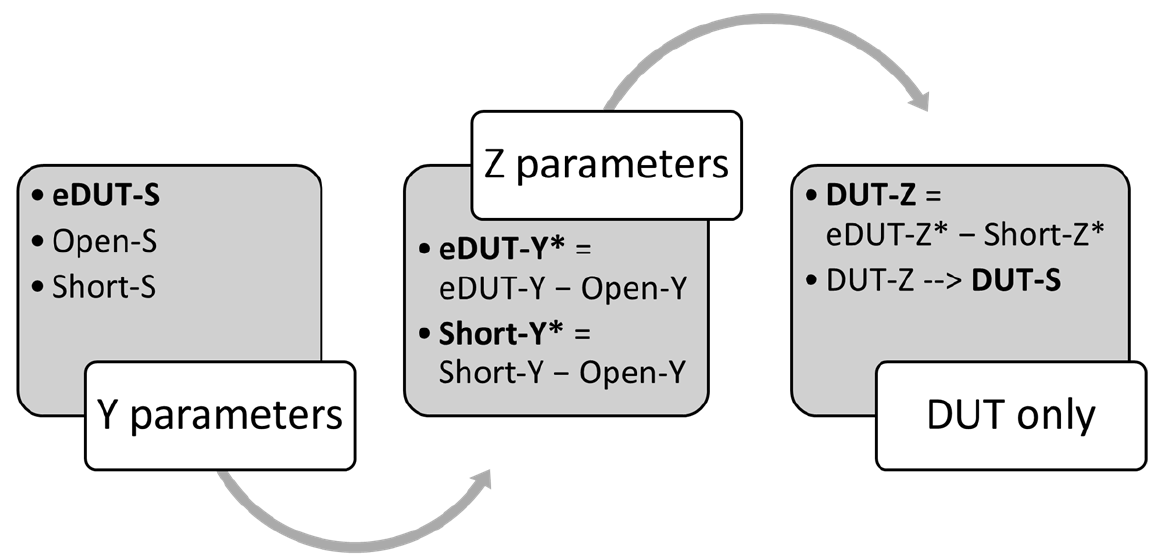
Figure 5. RF (radio frequency) measurements CPW pads de-embedding process flow, “S” in the first group refers to S-parameters.